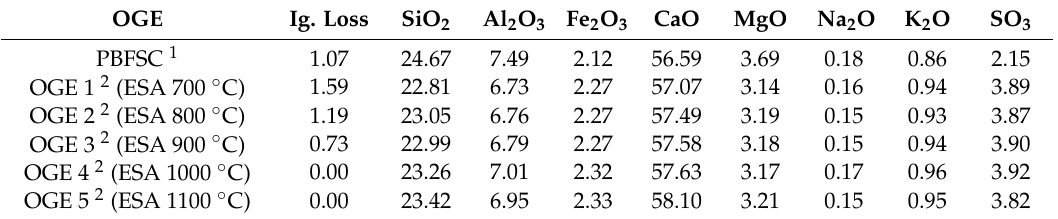
Table 4. Change in chemical composition of OGE at different ESA burning temperatures (%).